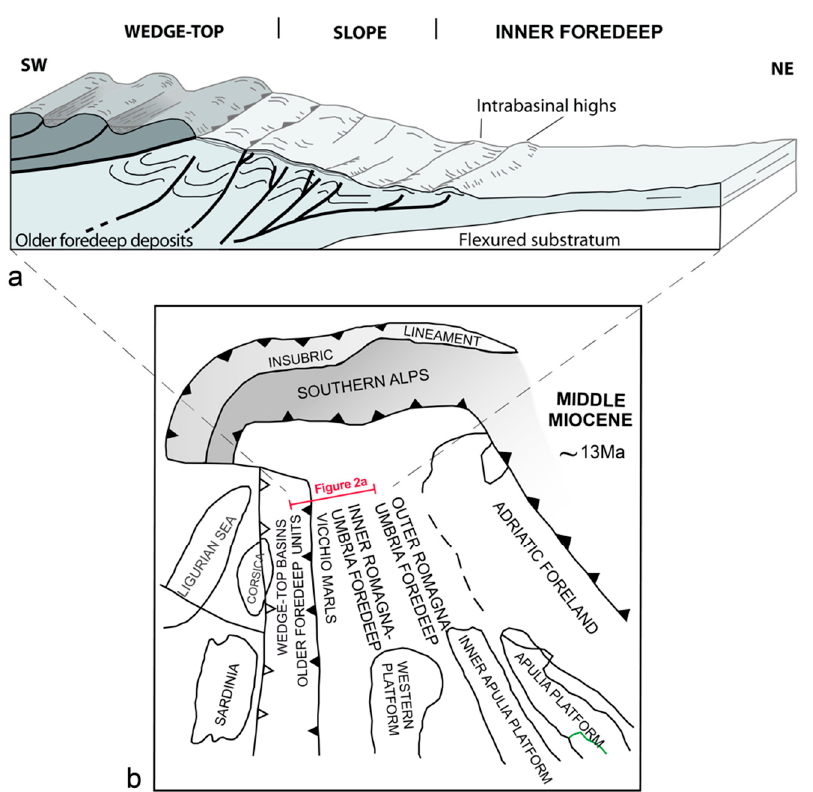
Figure 2. ( a ) Block diagram showing the northern Apennine wedge-foredeep system during the Miocene. Seep carbonates occurred in wedge-top basins, on the slope and in the inner foredeep basin. ( b ) Simplified paleogeographic sketch of the Apennine domains during the middle Miocene (modified from [26] ). Table 1. Structural distribution and paleogeographic domain of the examined outcrops (described in the text).